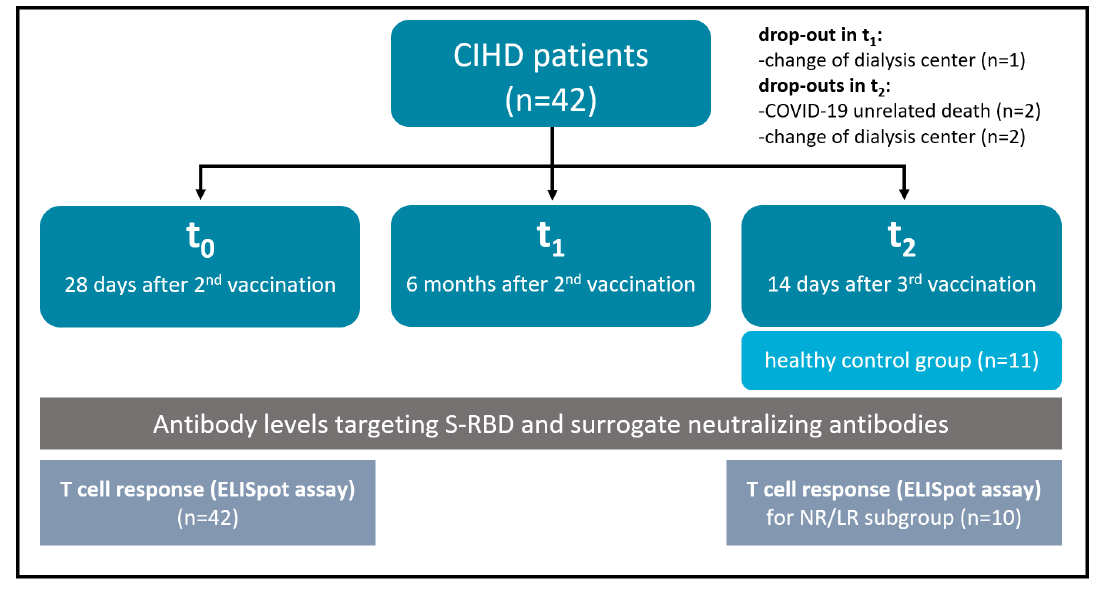
Figure 1. Illustration of the study setup. Samples were collected at three different time points to evaluate the dynamic of the patients’ immunization status by different immunoassays. Abbreviations: CIHD (chronic intermittent hemodialysis); S-RBD (spike receptor binding domain); ELISpot (enzyme-linked immunospot).